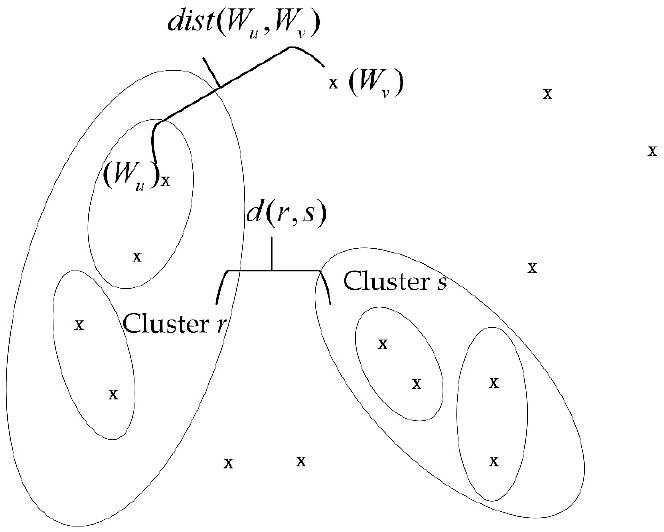
Figure 4. Distance between variables and between clusters.